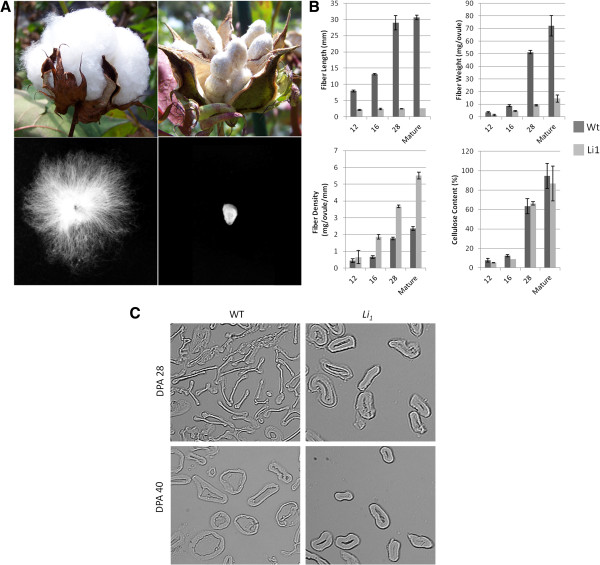
Phenotype of the Li1 mutant and its wild type. A) Comparison of phenotypes observed in wild type DP5690 and Li1/ Li1 mutant under field conditions after opening (top row) and of single individual seeds (bottom row). B) Measurements of fiber length, mass, density and fiber cellulose content in the wild type (DP5690) and Li1/ Li1 mutant. C) Cross-sectional images of fibers from 28 and 40 DPA wild type (WT) and Li1 mutant fibers (200× magnification).